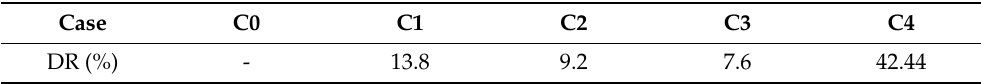
Table 5. Percentage of drag reduction of ridge and post-type cases (C1~C4).